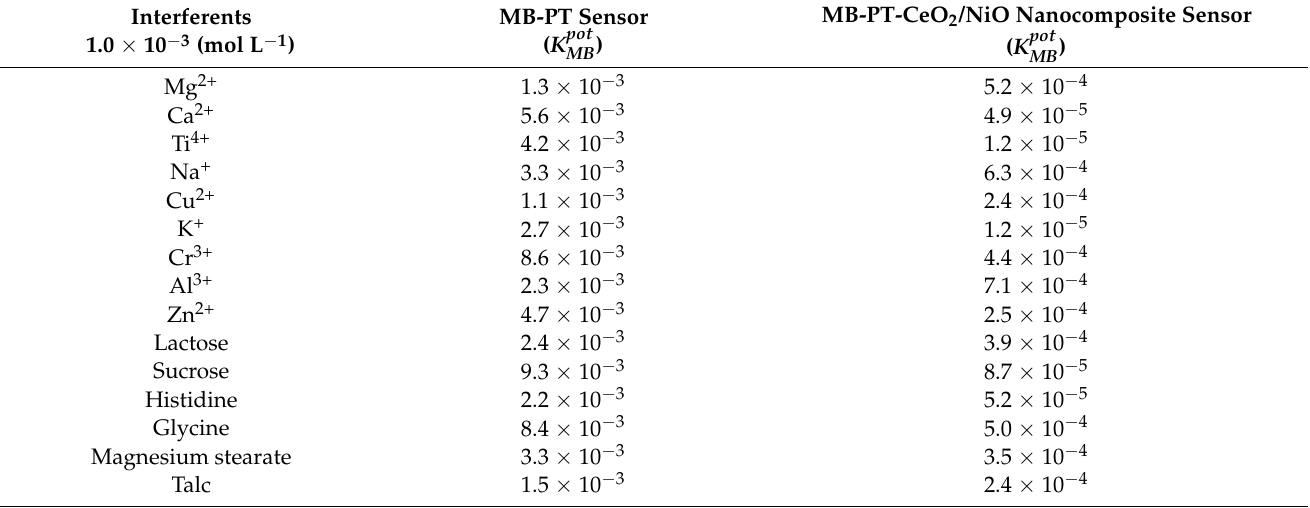
Table 2. Tolerable values ( K pot ) of the designed MB-PT and MB-PT-CeO 2 /NiO nanocomposite MB sensors estimated by separate solution technique using 1.0 × 10 − 3 mol L − 1 MB and foreign material solution